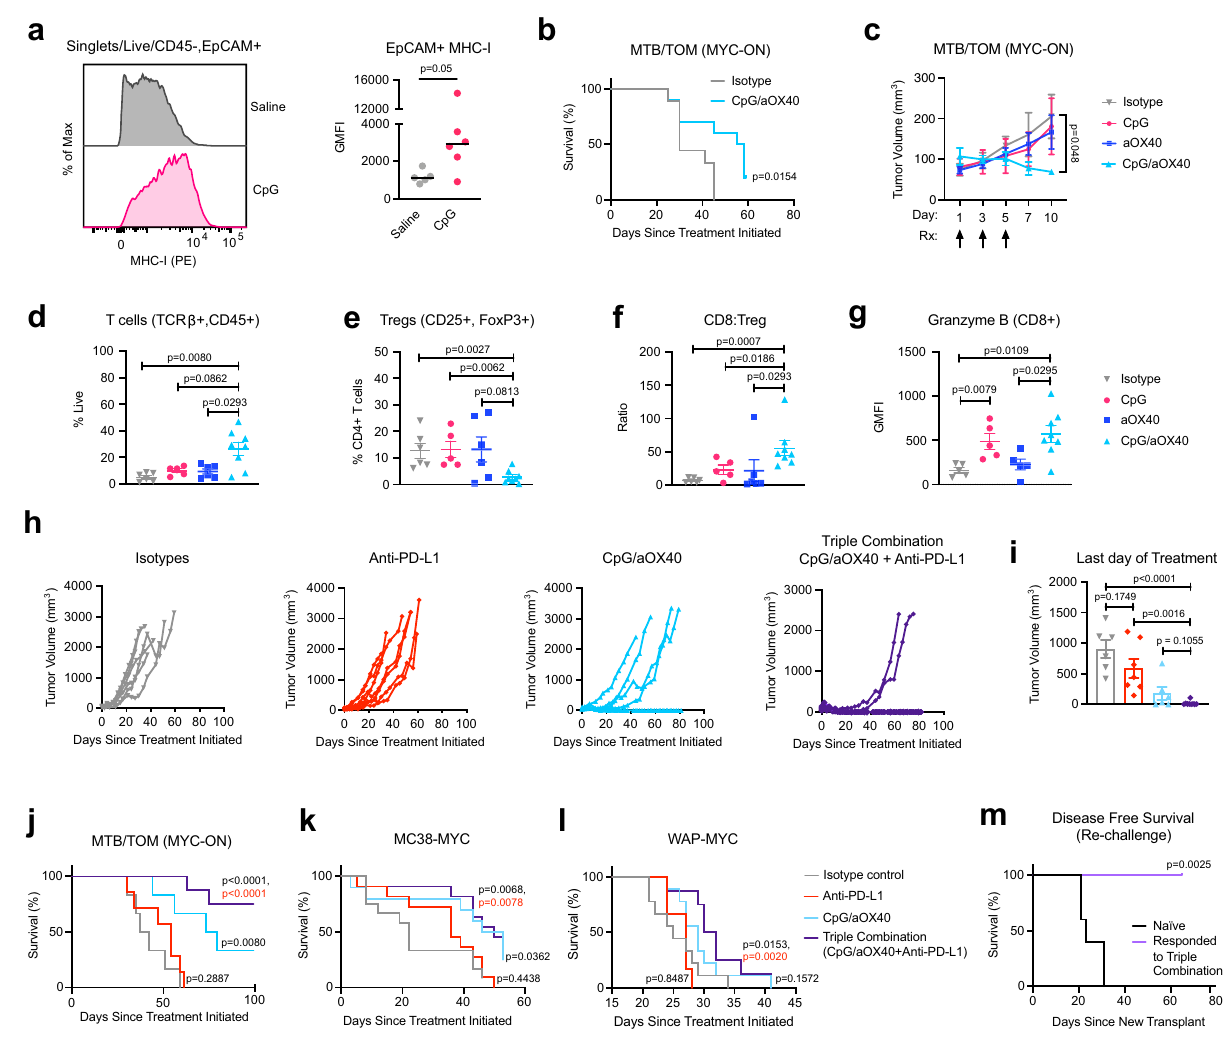
Fig. 4 CpG/aOX40 enhances anti-PD-L1 in vivo. a Representative histogram of cell surface MHC-I detected by fl ow cytometry. Adjacent bar graph displaying geometric mean fl uorescence intensity (GMFI). Line represents median, data points represent individual animals, saline ( n = 5), CpG ( n = 6), Mann – Whitney test, exact p -value. b Survival (time to endpoint length: 20 mm) for animals given CpG/anti-OX40 (aOX40) ( n = 10) or isotype/vehicle ( n = 9). Log rank test, exact p -value. c Tumor volume following treatments (Rx) indicated by arrows. Isotype ( n = 6), CpG ( n = 5), aOX40 ( n = 6), CpG/ aOX40 ( n = 5). Mean ± S.E.M, two-sided, unpaired t -test comparing tumor volume on day 10 in isotype treated vs. CpG/aOX40, exact p -value. d – g Flow cytometry analysis of immune cells found in the tumor post-treatment initiation day 10. Isotype ( n = 6), CpG ( n = 5), anti-OX40 ( n = 6), CpG/aOX40 ( n = 8). Mean± S.E.M., Mann – Whitney test., exact p -values: d Percent of live cells in the tumor that are T-cells. e Percent of CD4 + (gating: Singlets/Live/ TCR β + , CD45 + /CD8 − , CD4 + ) T-cells that are CD25 + and FOXP3 + . f Ratio of CD8 + (gating: Singlets/Live/TCR β + , CD45 + /CD8 + , CD4 − ) T-cell counts to Treg counts (gating: Singlets/Live/TCR β + , CD45 + /CD8 − , CD4 + /CD25 + , FOXP3 + ). g Geometric mean fl uorescence intensity for intracellular granzyme B in the CD8 + T-cells (gating: Singlets/Live/TCR β + , CD45 + /CD8 + , CD4 − ). h MTB/TOM tumor volumes graphed to endpoint: isotype ( n = 6), anti-PD-L1 ( n = 7), CpG/aOX40 ( n = 6), and triple combination ( n = 9). i Tumor volume in MTB/TOM animals after last day of treatment (related to panel h ). Mean ± S.E.M., two-sided, unpaired t -test, exact p -value. j – l Survival (time to ethical endpoint length = 20 mm). Log rank test for each treatment arm in comparison to isotype arm, exact p -value in black. Log rank test for anti-PD-L1 compared to triple combination, exact p -value in red: j MTB/TOM (MYC-ON) animals from panel h . k MC38-MYC model, isotype ( n = 12), anti-PD-L1 ( n = 11), CpG/aOX40 ( n = 10), triple combination ( n = 11). l WAP-MYC model, isotope ( n = 9), anti-PD-L1 ( n = 6), CpG/anti-OX40 ( n = 9), and triple combination ( n = 8). m Disease-free survival in MTB/ TOM model (de fi ned as time to palpable tumor). Mice previously treated with triple combination and eradicated their tumors were transplanted with a new MTB/TOM tumor on the contralateral side. Tumor naïve group ( n = 5) and responded to therapy group ( n = 5). Log rank test, exact p -value. Source data are provided in the Source Data fi